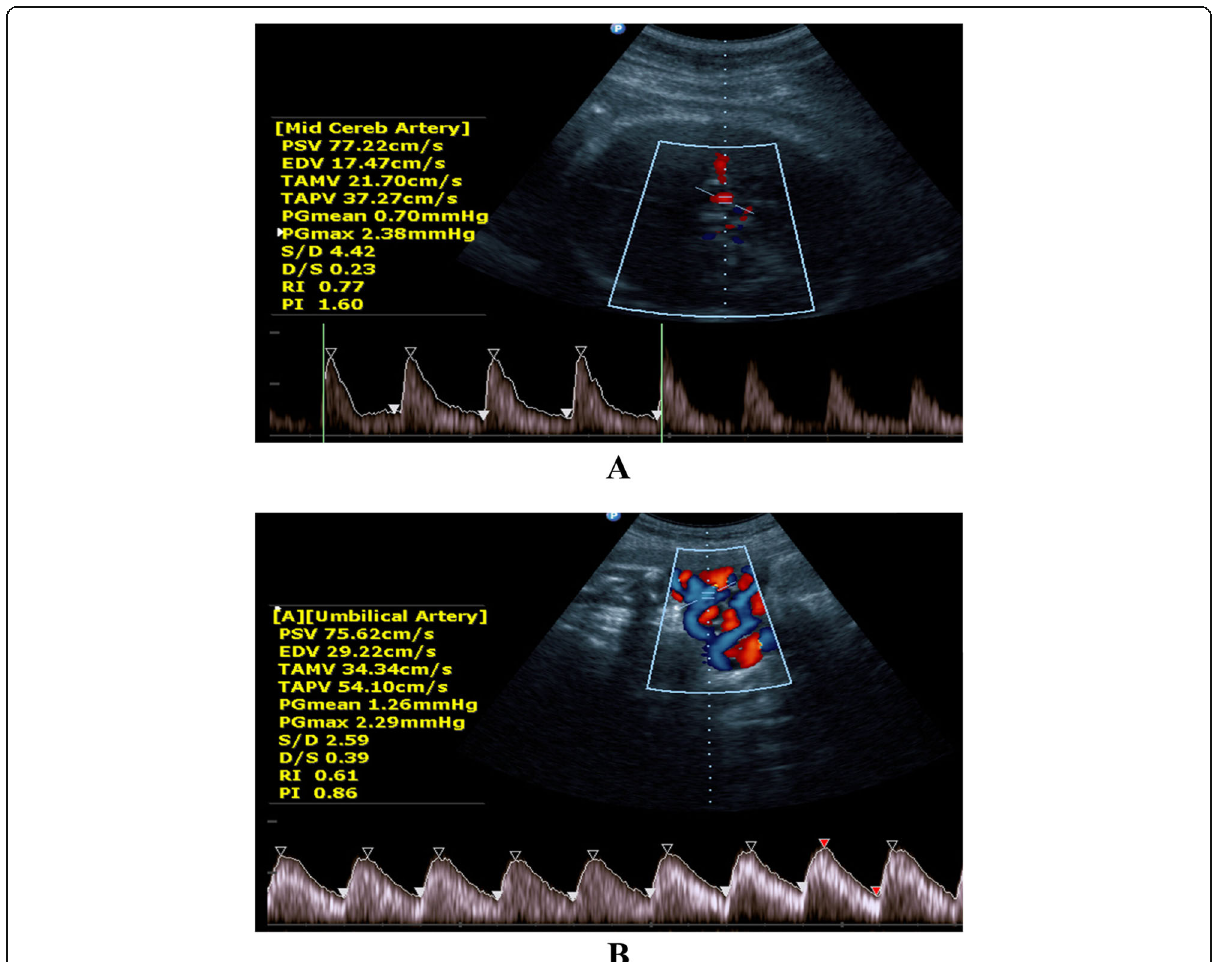
Fig. 6 Normal Doppler imaging of MCA and UA at 30 weeks of gestational age in a 24-year-old female mother. FHR, 148 b/m; placenta grade II; and EFW, 1564 g. a Doppler US examination of fetal MCA revealed PSV = 77.22, S/D = 4.42, RI = 0.77, and PI = 1.60. b Doppler US examination of maternal UA revealed PSV = 75.62, S/D = 2.59, RI = 0.61, and PI = 0.86. CPR Doppler values: PSV = 1.02, S/D = 1.7, RI = 1.26, and PI =